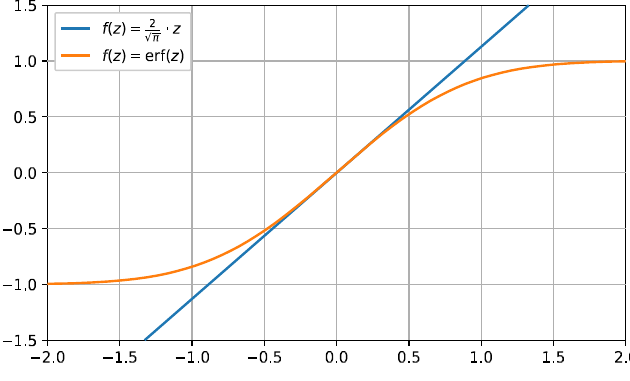
Figure 4. Error function decay illustration.